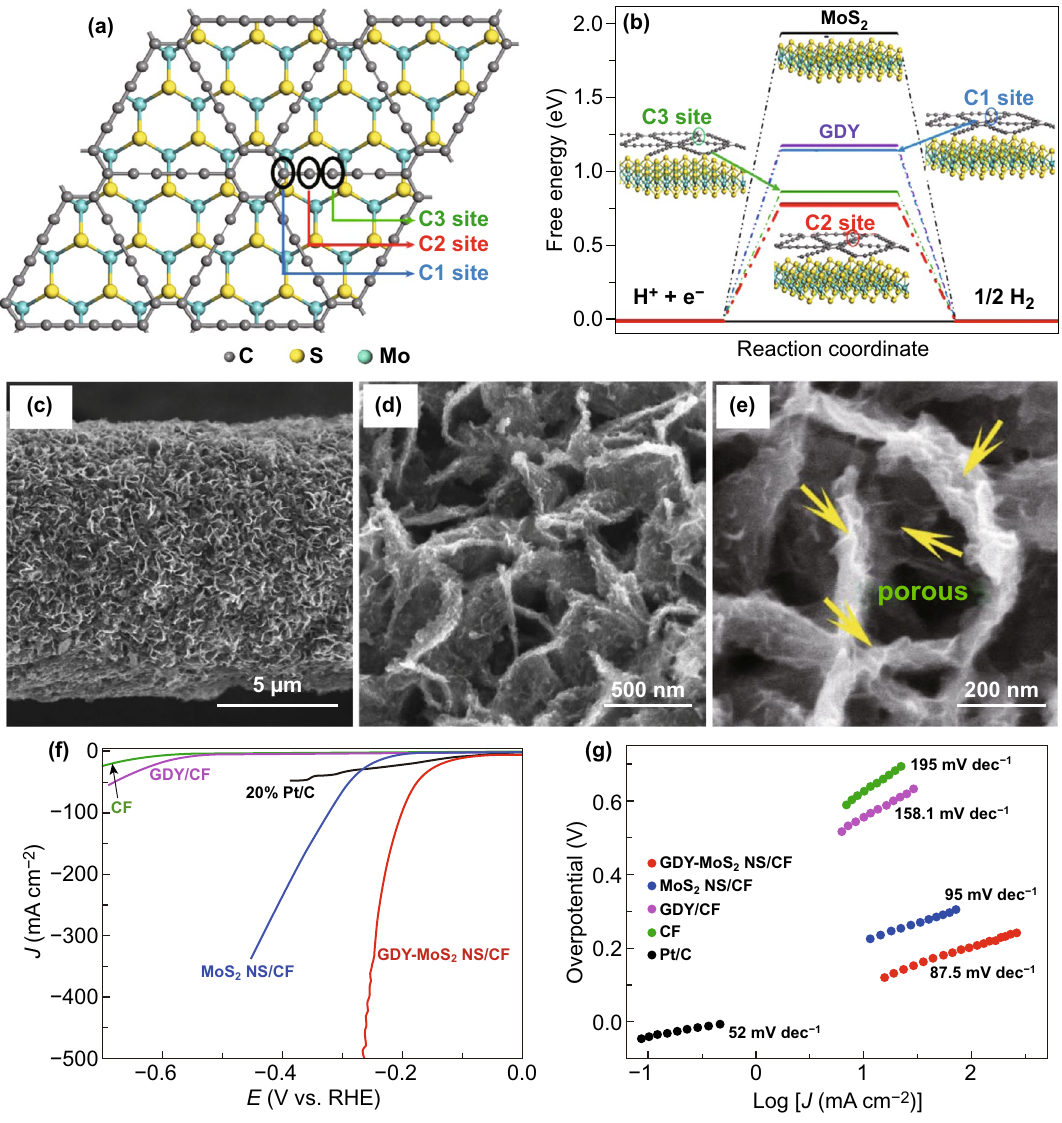
Fig. 6 a Top view of the optimized GDY-MoS 2 , b calculated free energy of HER at equilibrium potential for MoS 2 , GDY and different sites in GDY-MoS 2 hybrid, c‑e SEM images of GDY-MoS 2 NS/CF, f linear sweep voltammetry curves, and g corresponding Tafel plots of GDY-MoS 2 NS/CF, MoS 2 NS/CF, GDY/CF, CF, and Pt/C. Reproduced with permission from Ref. [111]. Copyright 2019